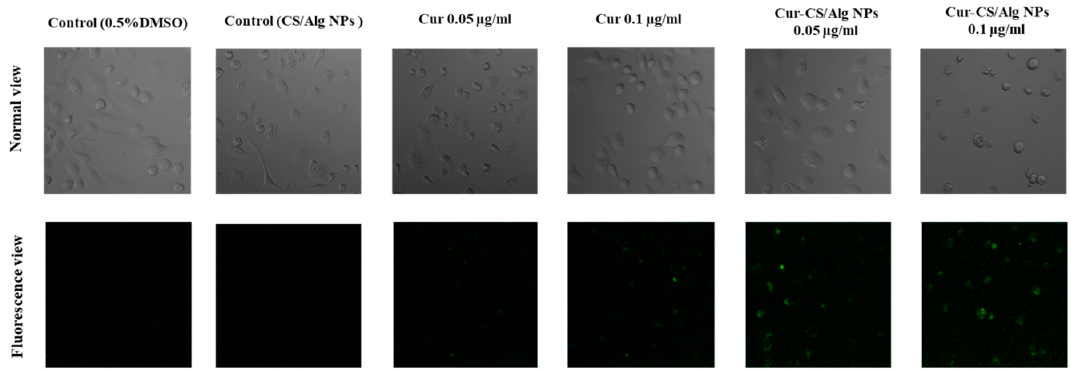
Figure 4. Cellular uptake of curcumin and Cur-CS/Alg NPs viewed by fluorescence microscopy in HaCaT cells.